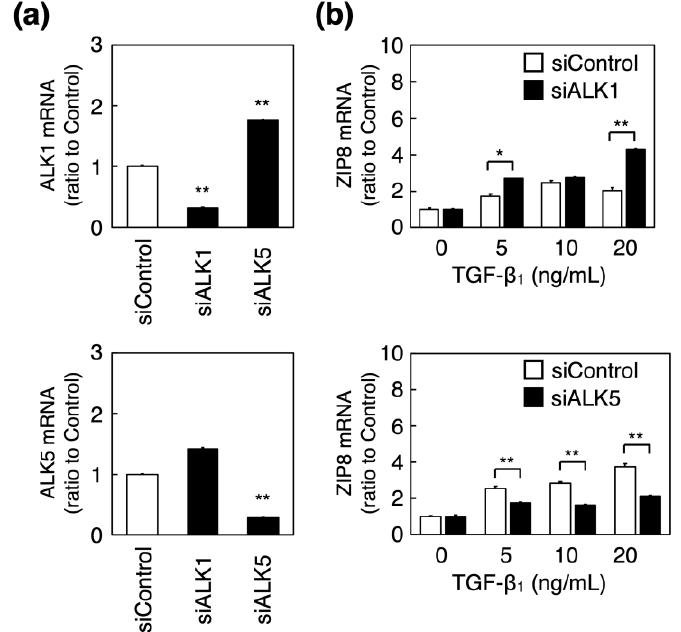
Figure 3. Involvement of ALKs in the induction of ZIP8 by TGF- β 1 in vascular endothelial cells. ( a ) Bovine aortic endothelial cells were transfected with control, ALK1, or ALK5 siRNAs for 24 h, and ALK1 and ALK5 mRNA expression levels were determined using real-time reverse transcription polymerase chain reaction (RT-PCR). Each value represents the mean ± S.E. of three technical replicates; and ** p < 0.01 represents statistical significance compared with the siControl. ( b ) Bovine aortic endothelial cells transfected with the control, ALK1, or ALK5 siRNA for 24 h were treated with or without TGF- β 1 (5, 10, or 20 ng/mL) for 6 h, and ZIP8 mRNA expression was measured using real-time RT-PCR. Each value represents the mean ± S.E. of three technical replicates; * p < 0.05, ** p < 0.01 compared with the corresponding TGF- β 1 -treated cells transfected with